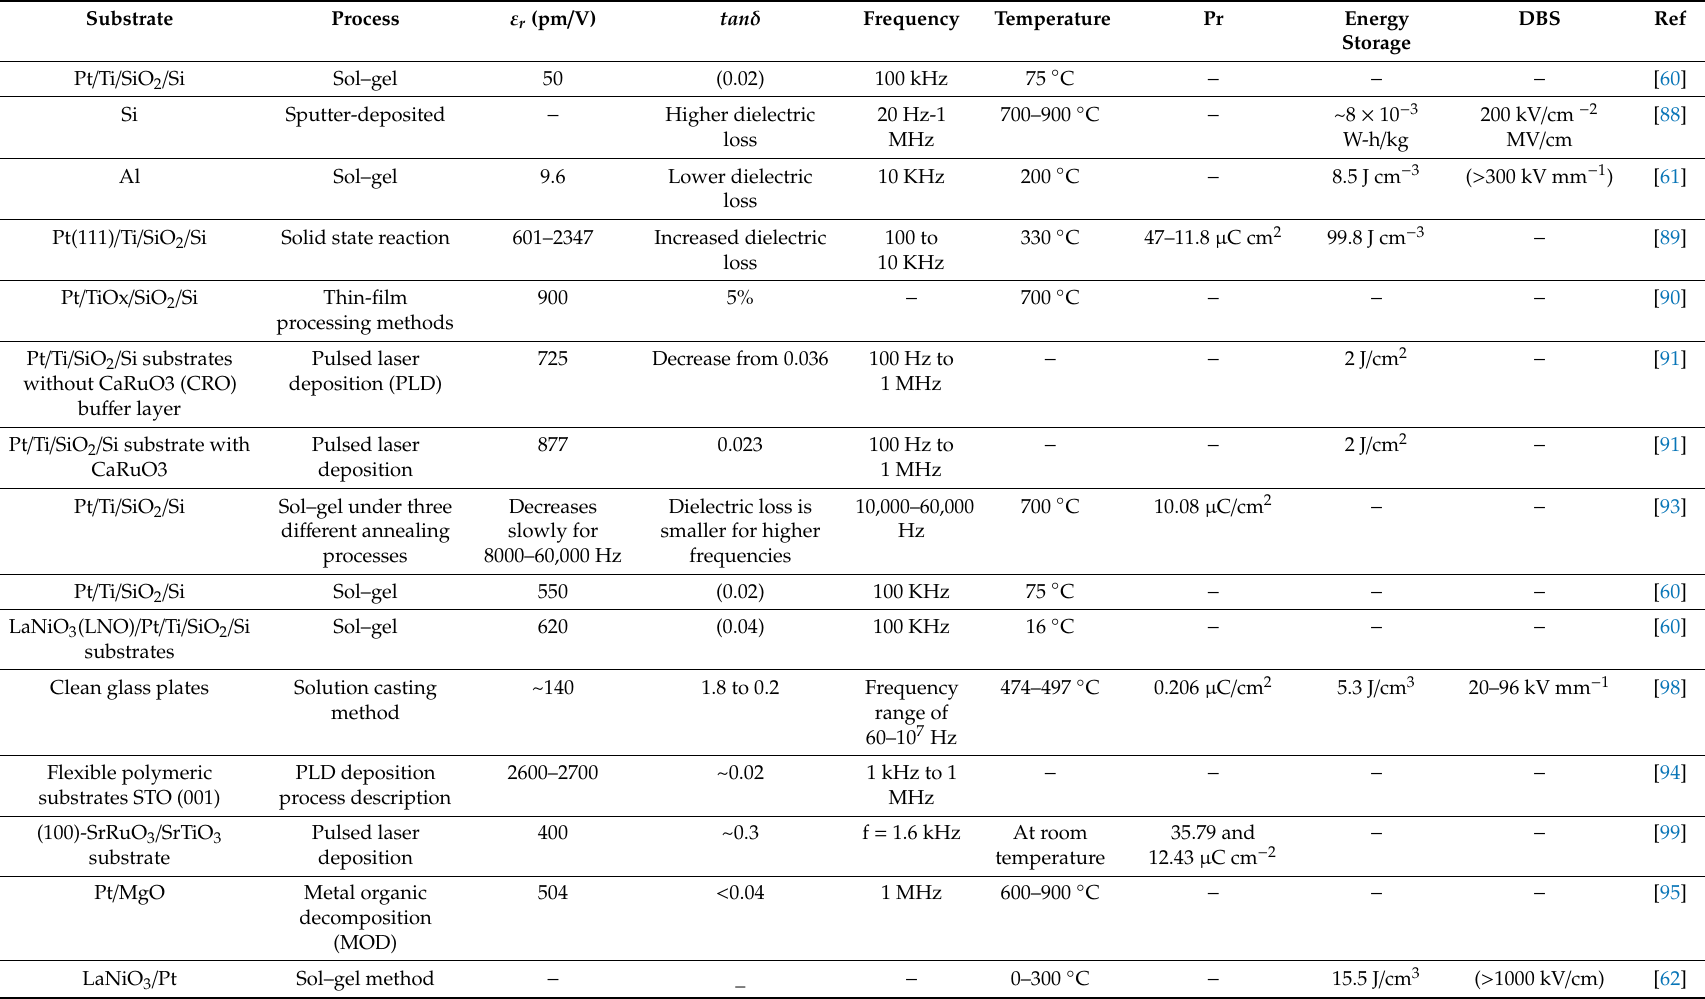
Table 2. Comparison of dielectric and energy storage properties of BCZT thin